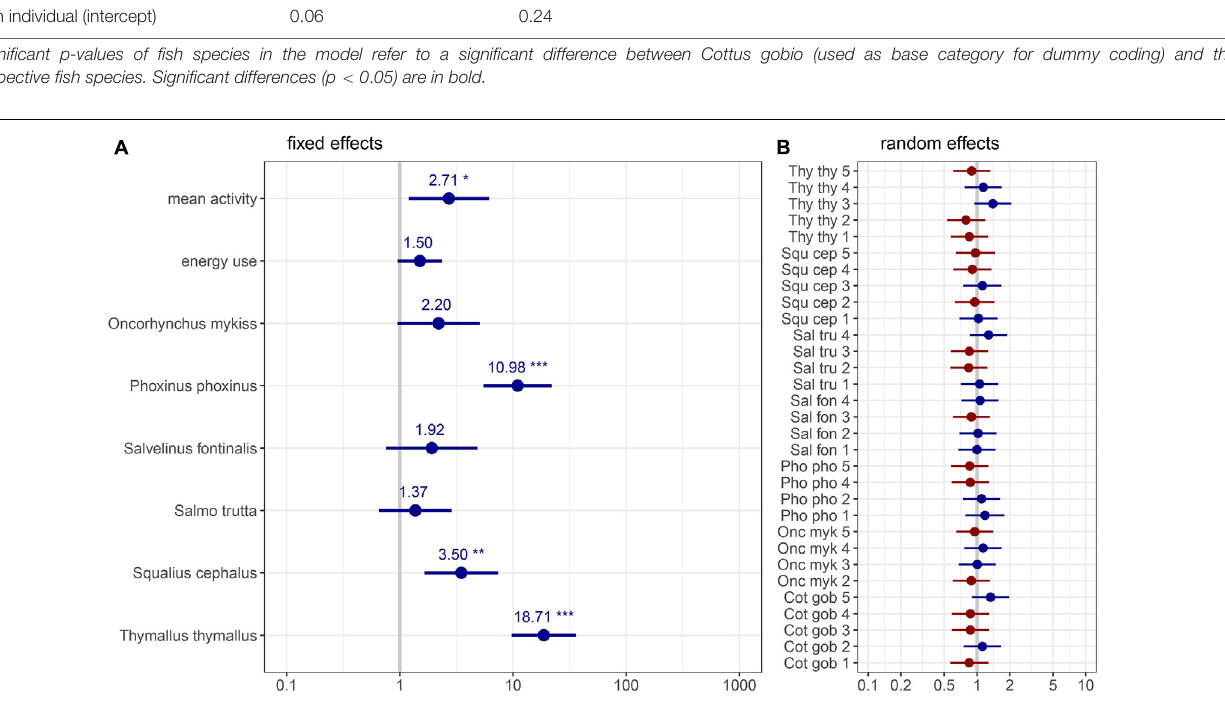
Frontiers in Ecology and Evolution |